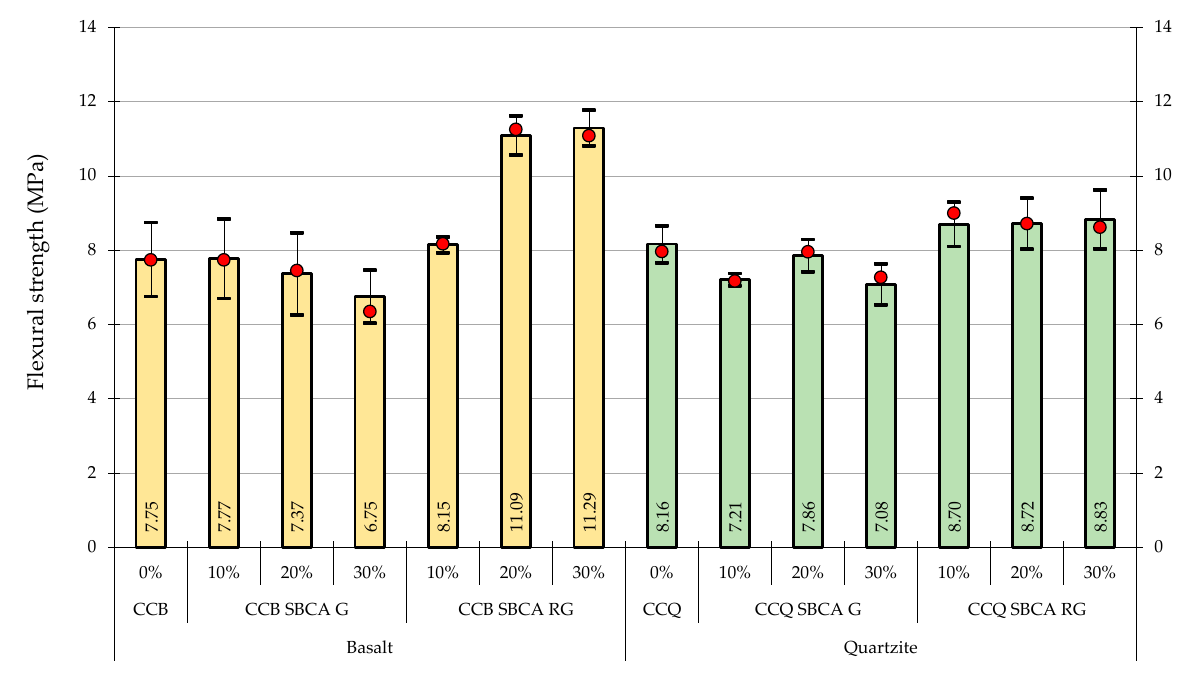
Figure 19. Flexural strength at 900 days of mortars after ASR test.